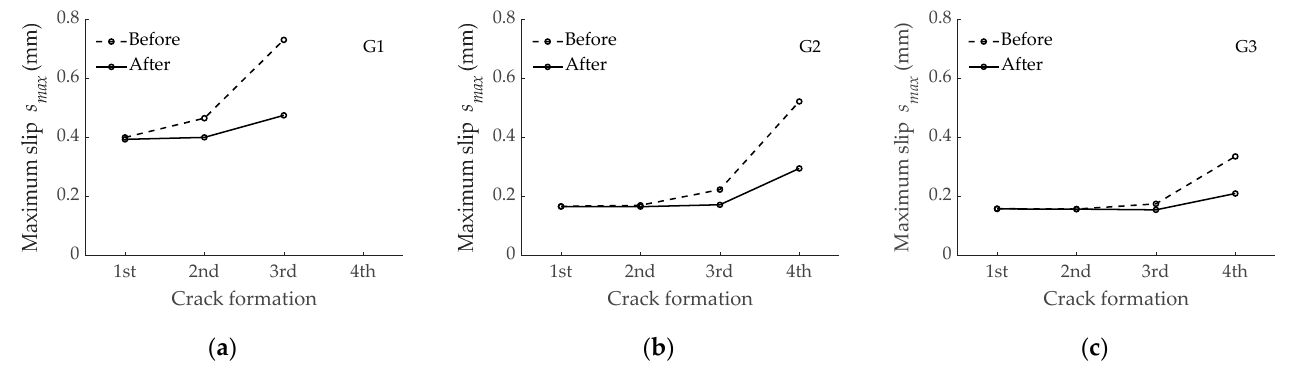
Figure 8. Maximum slips at the cracked section before and after the crack formation for the tensile element reinforced with: ( a ) G1 bar; ( b ) G2 bar; ( c ) G3 bar.